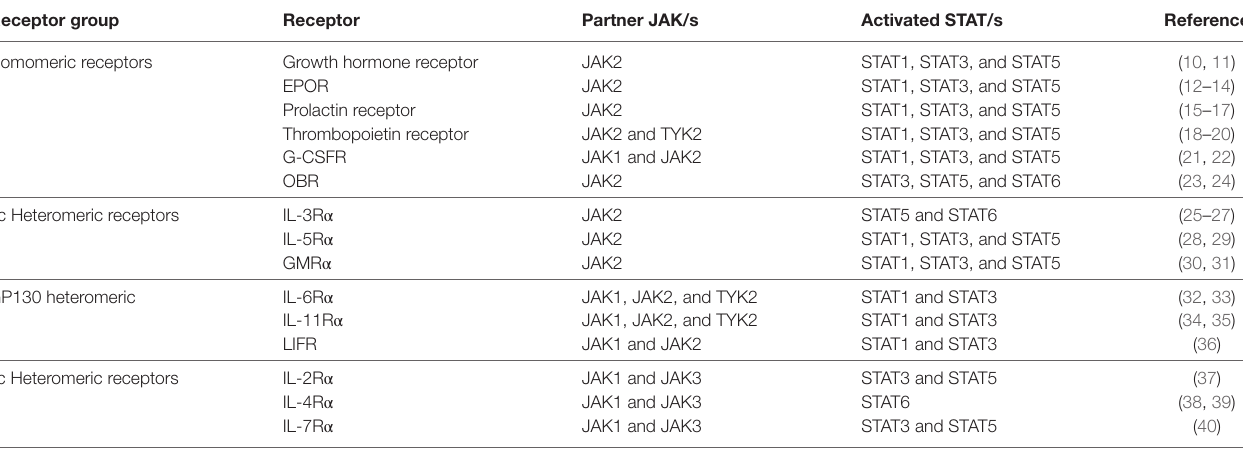
TAble 1 | Class I cytokine receptors and their Janus kinase (JAK)–signal transducer and activator of transcription (STAT) signaling partners.